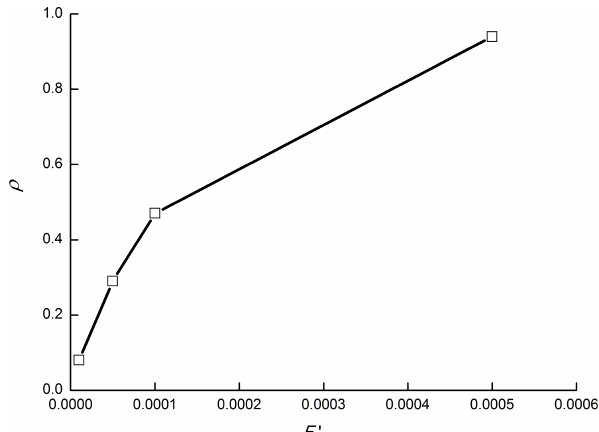
Figure 4. The relation between avalanche density ρ and disturbance